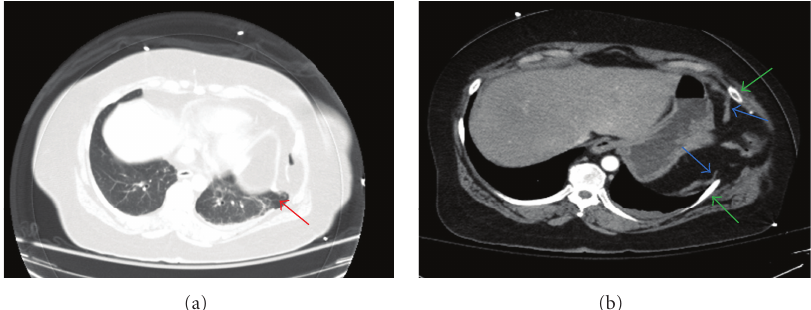
Figure 1: Axial CT images of the chest demonstrate herniation of lung beyond the thoracic cavity (red arrow) (a). There is discontinuity of the diaphragm (blue arrows) and widened intercostal space (green arrows). Herniation of abdominal contents is present including omentum and transverse colon into the chest and through the intercostal defect (b).